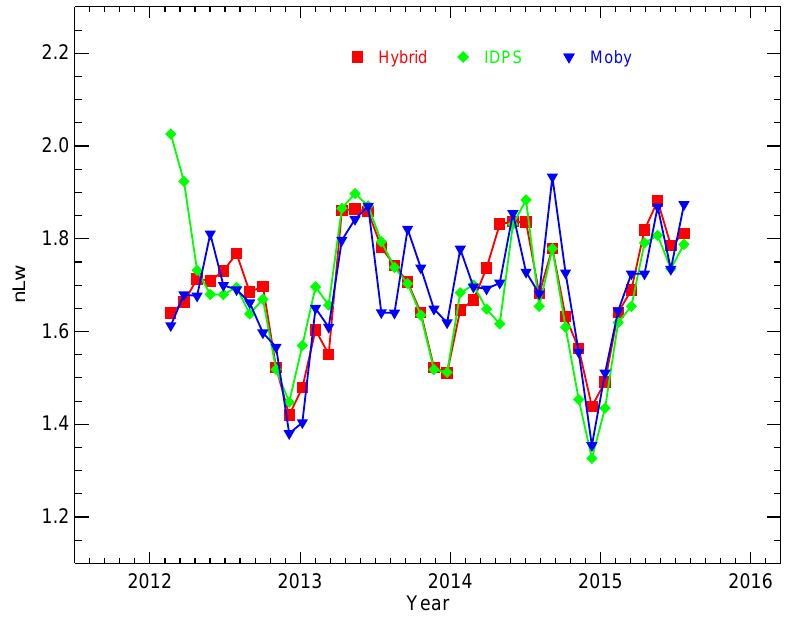
Figure 15. Ocean nL w ( λ ) trending for the band M2 along with MOBY in situ data.